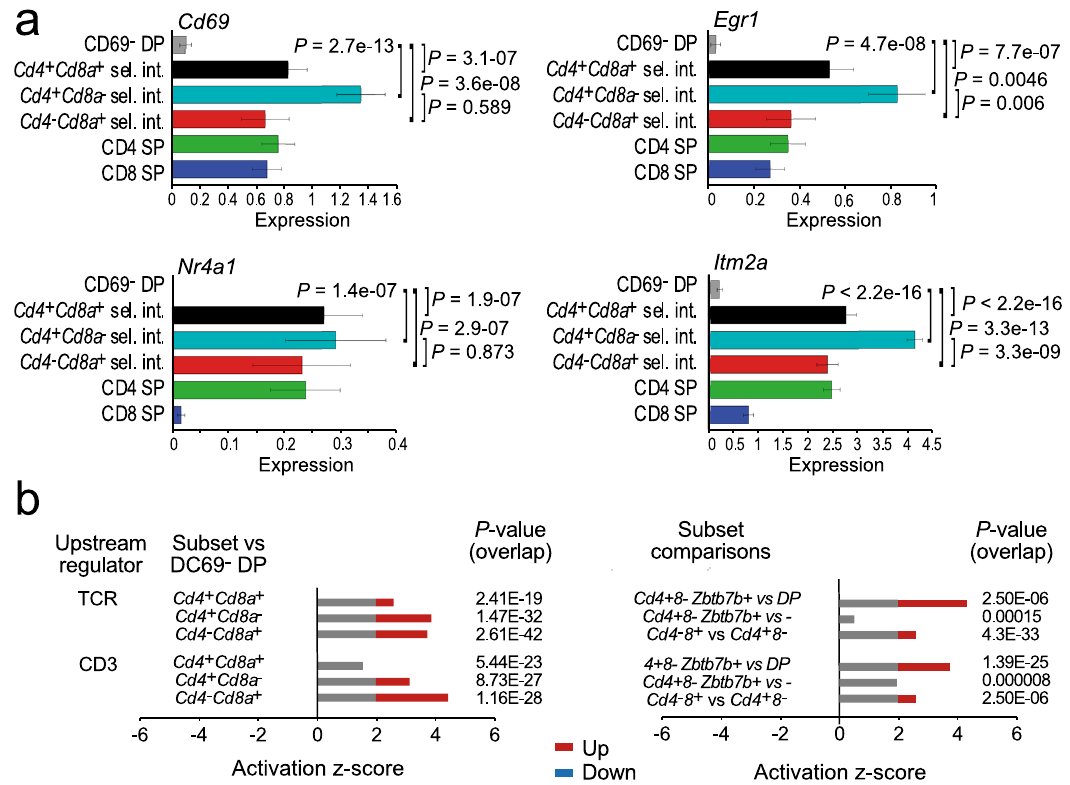
Fig. 3 Expression of TCR signalling genes by selection intermediates of de fi ned coreceptor gene expression status. a Expression of TCR activation genes Cd69, Egr1, Nr4a1 and Itm2a by selection intermediates of the indicated coreceptor status. Means and standard errors are shown. P -values are derived by two-sided Wilcoxon rank-sum test. Cell numbers are listed in Supplementary Tables 2 and 3. Source data are provided as a Source Data fi le. b IPA analysis of pathway activity downstream of the TCR and of CD3. Activation z -scores above 2 and below − 2 are considered signi fi cant. Selection intermediates versus CD69 − DP is shown on the left. Where available, comparisons between subsets of selection intermediates are shown on the right. Source data are provided as a Source Data fi